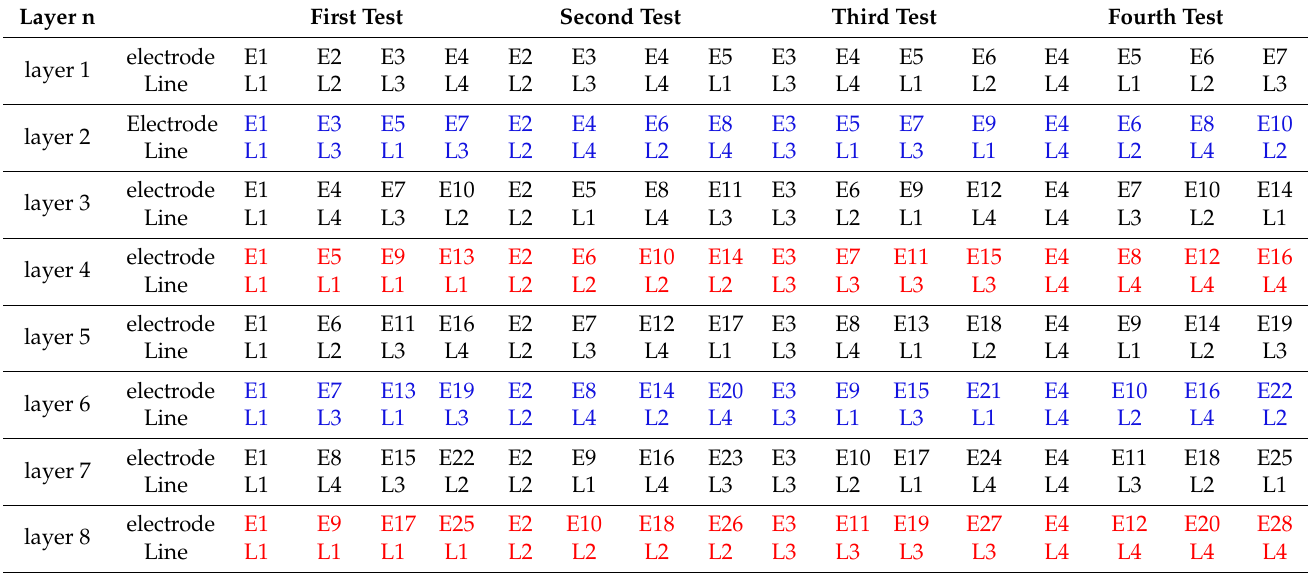
Table 1. Testing electrodes and the corresponding lines.